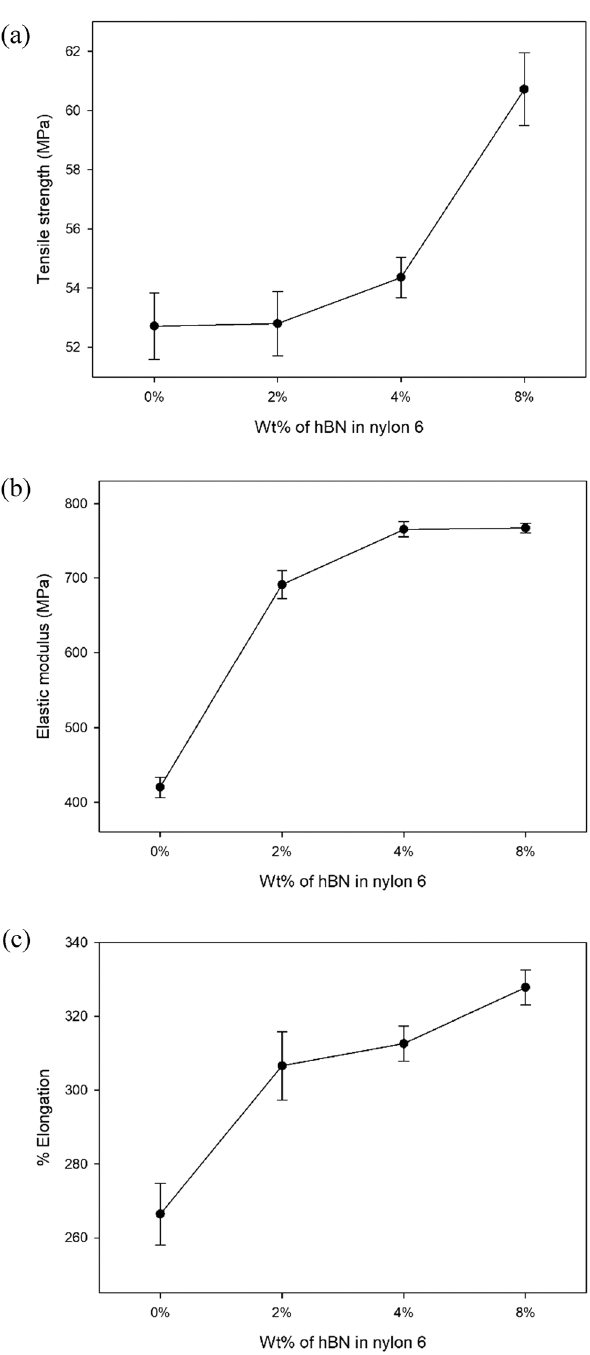
Figure 4: Tensile test results: ( a ) tensile strength, ( b ) modulus of elasticity, and ( c ) %